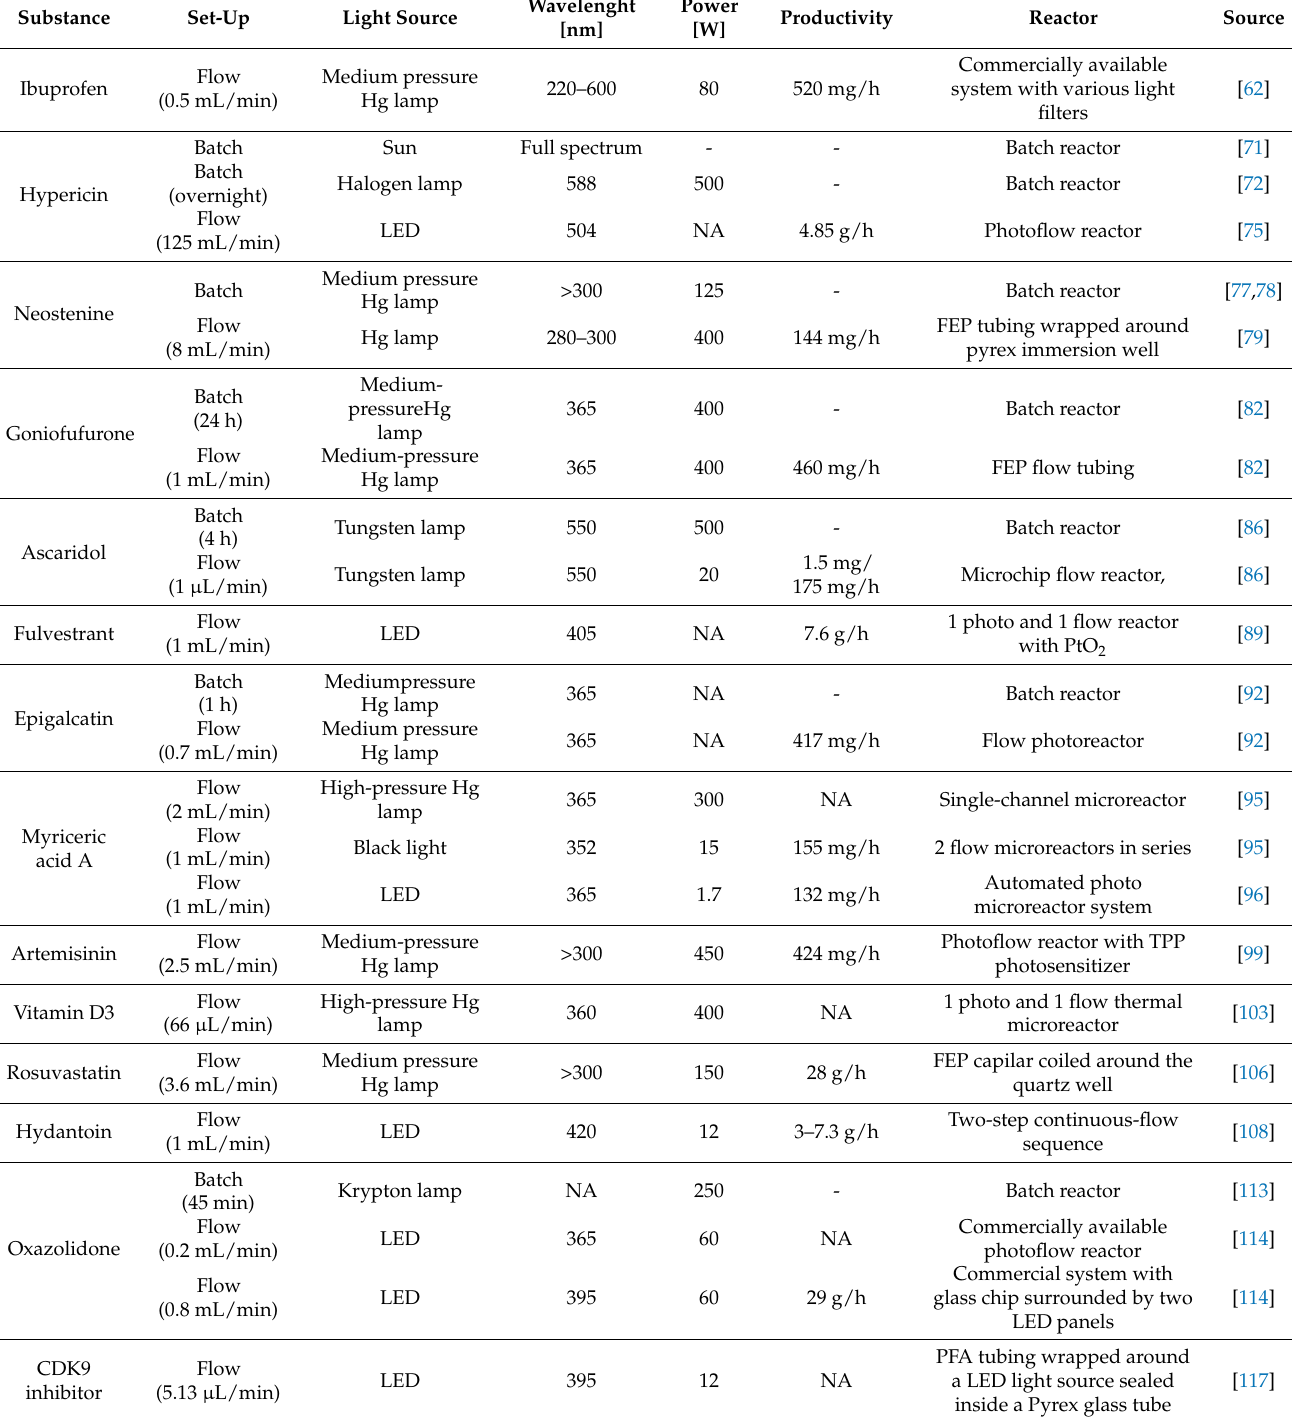
Table 2. Summary table of photochemical preparations of APIs.